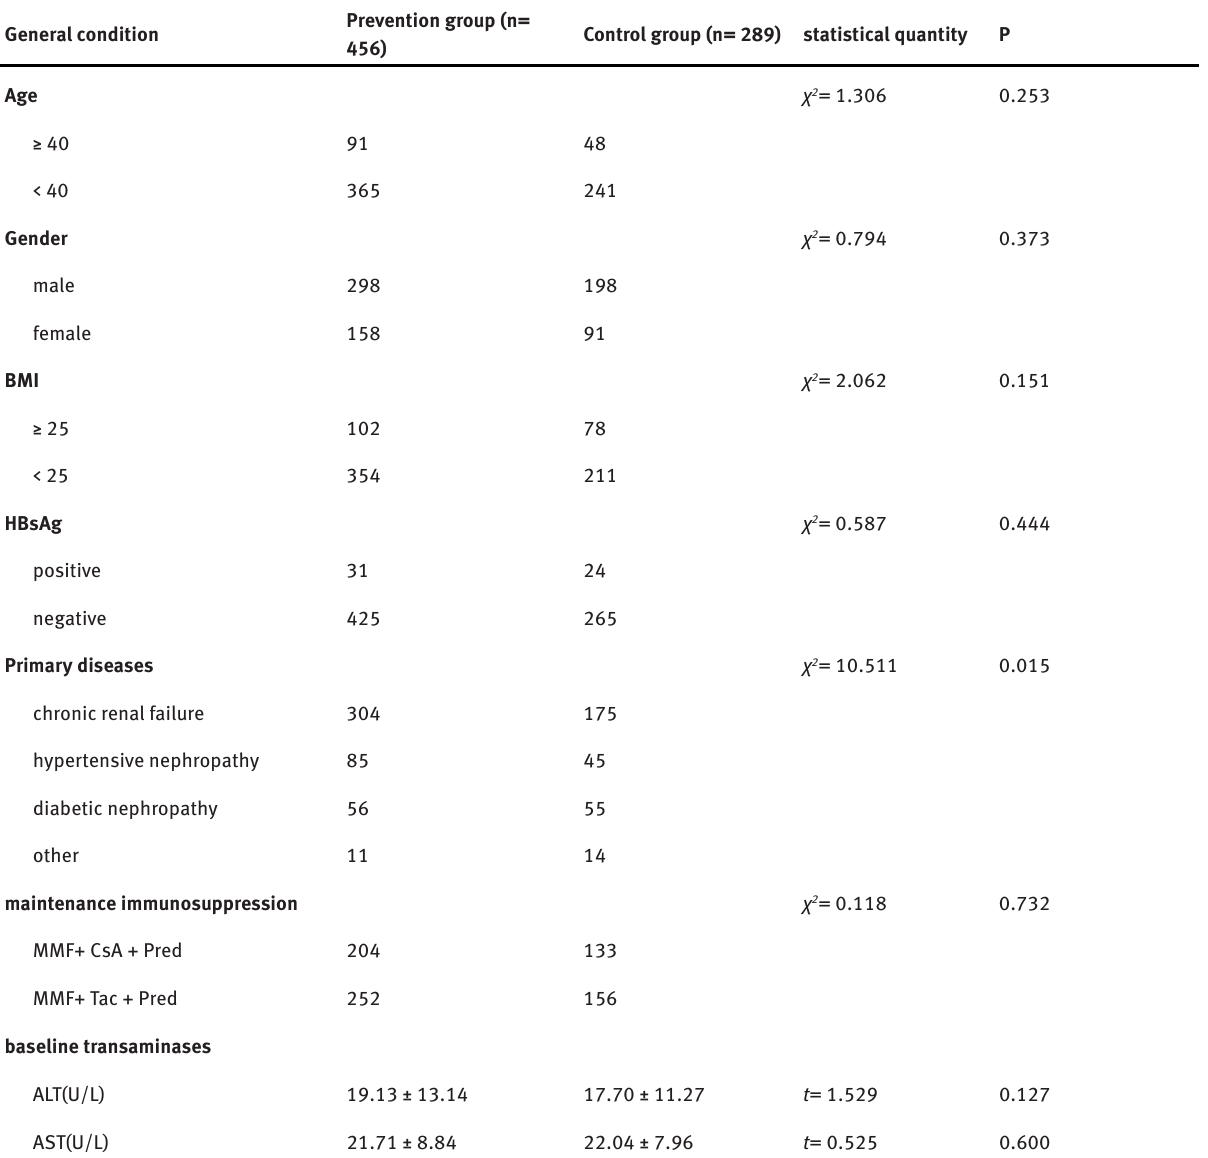
Table 1: Comparison of baseline characteristics of the two groups